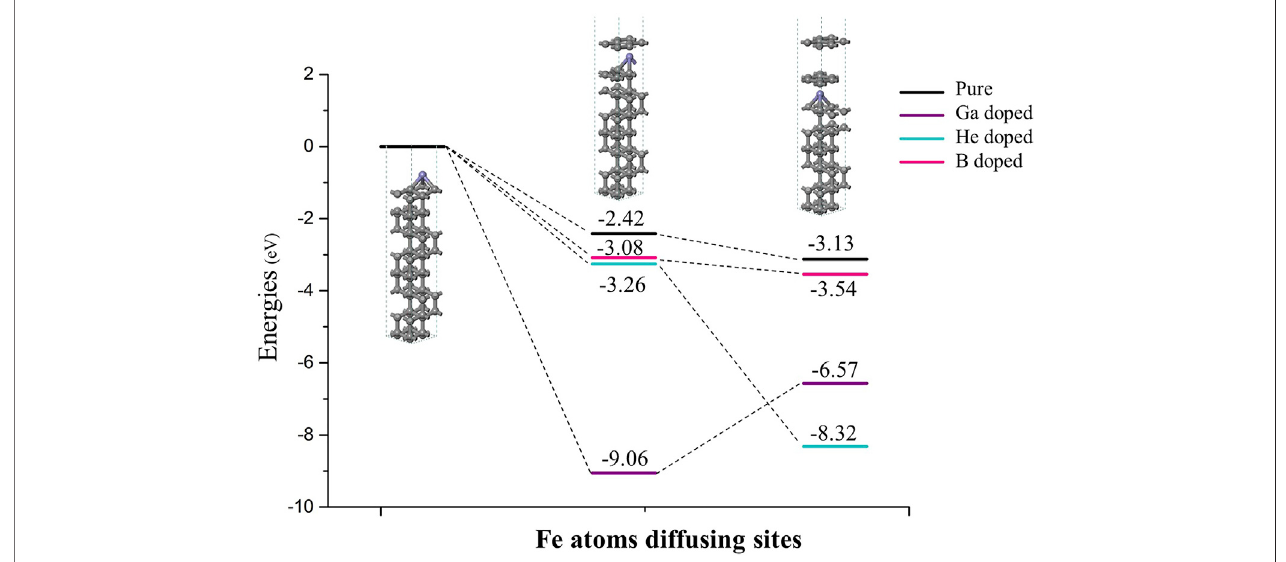
FIGURE 10 | As Fe atoms diffusing into the diamond lattice, thermodynamic effects of different doping on graphitization. The black lines represent the pristine systems without dopants; purple, sky blue and pink lines represent the Ga, He and B doped systems.